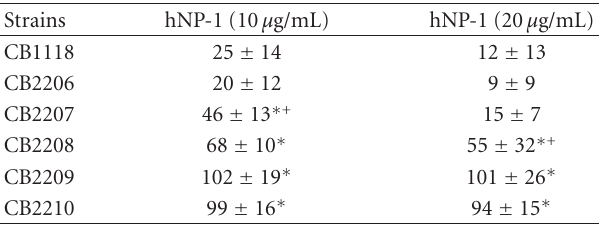
Table 2: In vitro susceptibility profiles to host defense peptides